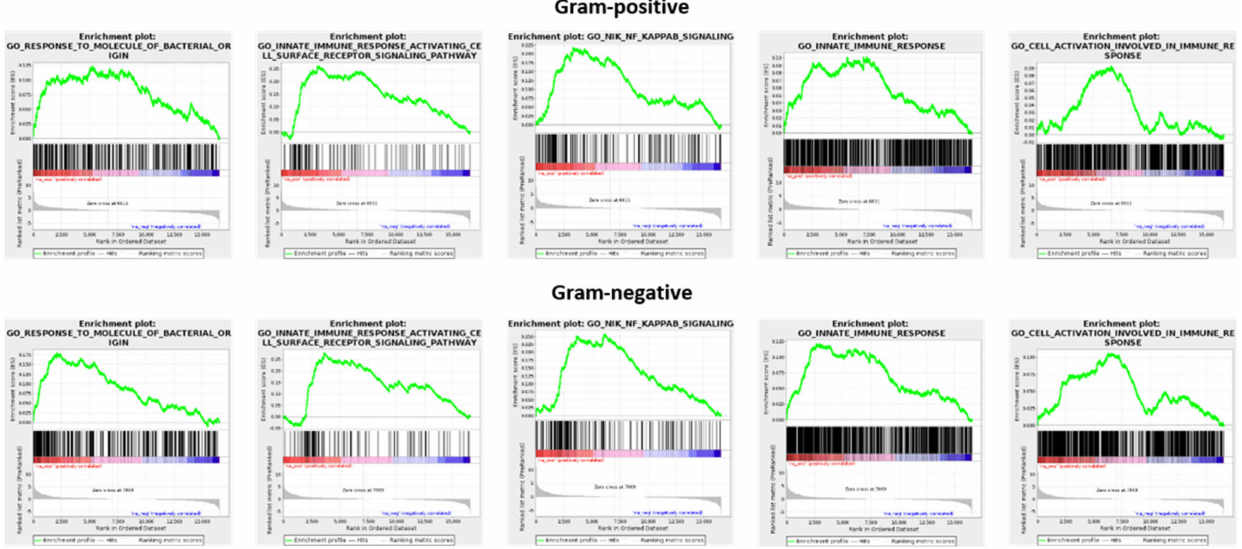
Figure 2. Gene set enrichment analysis (GSEA) applied to expression changes of protein-coding genes found in the comparison of unstimulated and stimulated macrophages. For stimulation, either LTA (Gram-positive setting) or LPS (Gram-negative setting) was used. Table 2. Target genes of miRNAs that were altered in expression after TLR stimulation were identified using the miRWalk